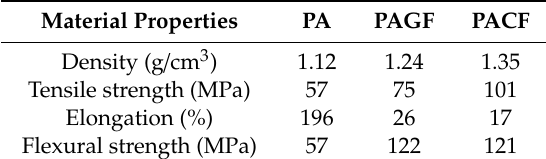
Table 1. Material properties of the print filaments.